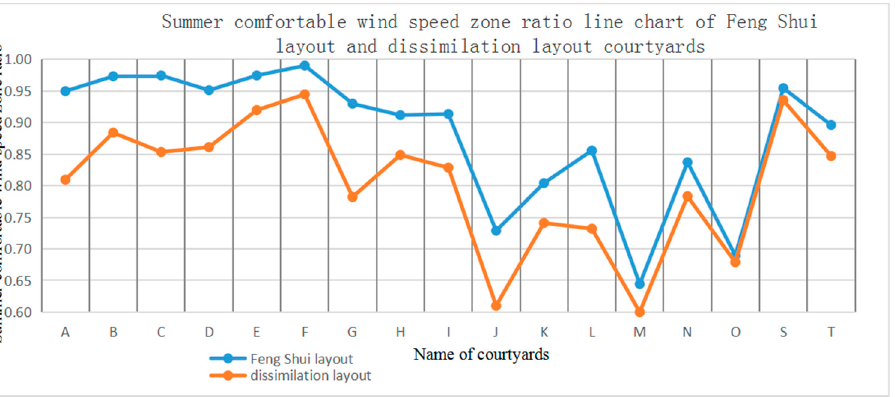
Figure 10. The comfortable wind speed zone ratio line chart for the courtyards of feng shui layout and dissimilation layout in summer. The values of the figure was based on CFD simulation results.